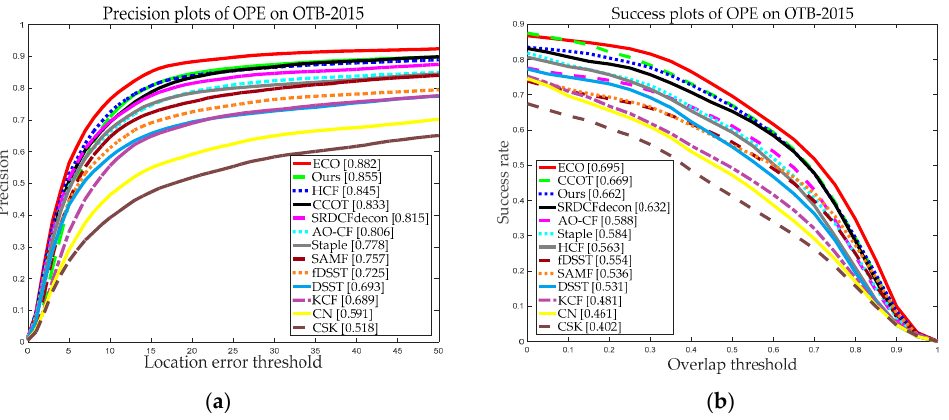
Figure 8. Precision and success plots on the dataset OTB-2015 using OPE. ( a ) Precision plots of OPE on OTB-2015; ( b ) Success plots of OPE on OTB-2015. In the legends, the average DP rates at a threshold of 20 pix and AUC scores at a threshold of 0.5 are reported for the precision plots and success plots,